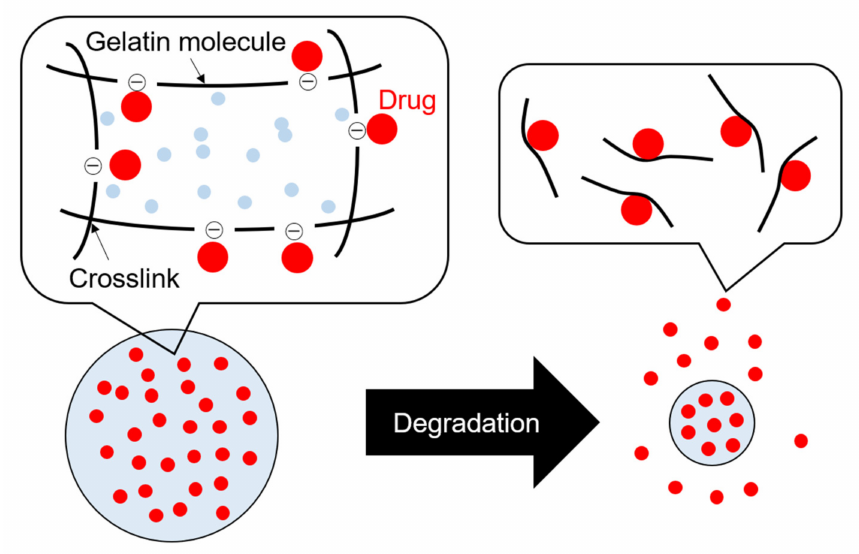
Figure 1. A schematic representation of drug release from gelatin particles (when the isoelectric point of gelatin is negative.). The gelatin used for sustained drug release can be selected considering the isoelectric point of the drug (If the drug to be released is basic, gelatin with a negative charge is preferable.). Drugs and gelatin molecules interact by physicochemical interaction (e.g., ionic or hydrogen interaction). When the gelatin particles are degraded, the drugs with gelatin molecule debris are rapidly released with time.